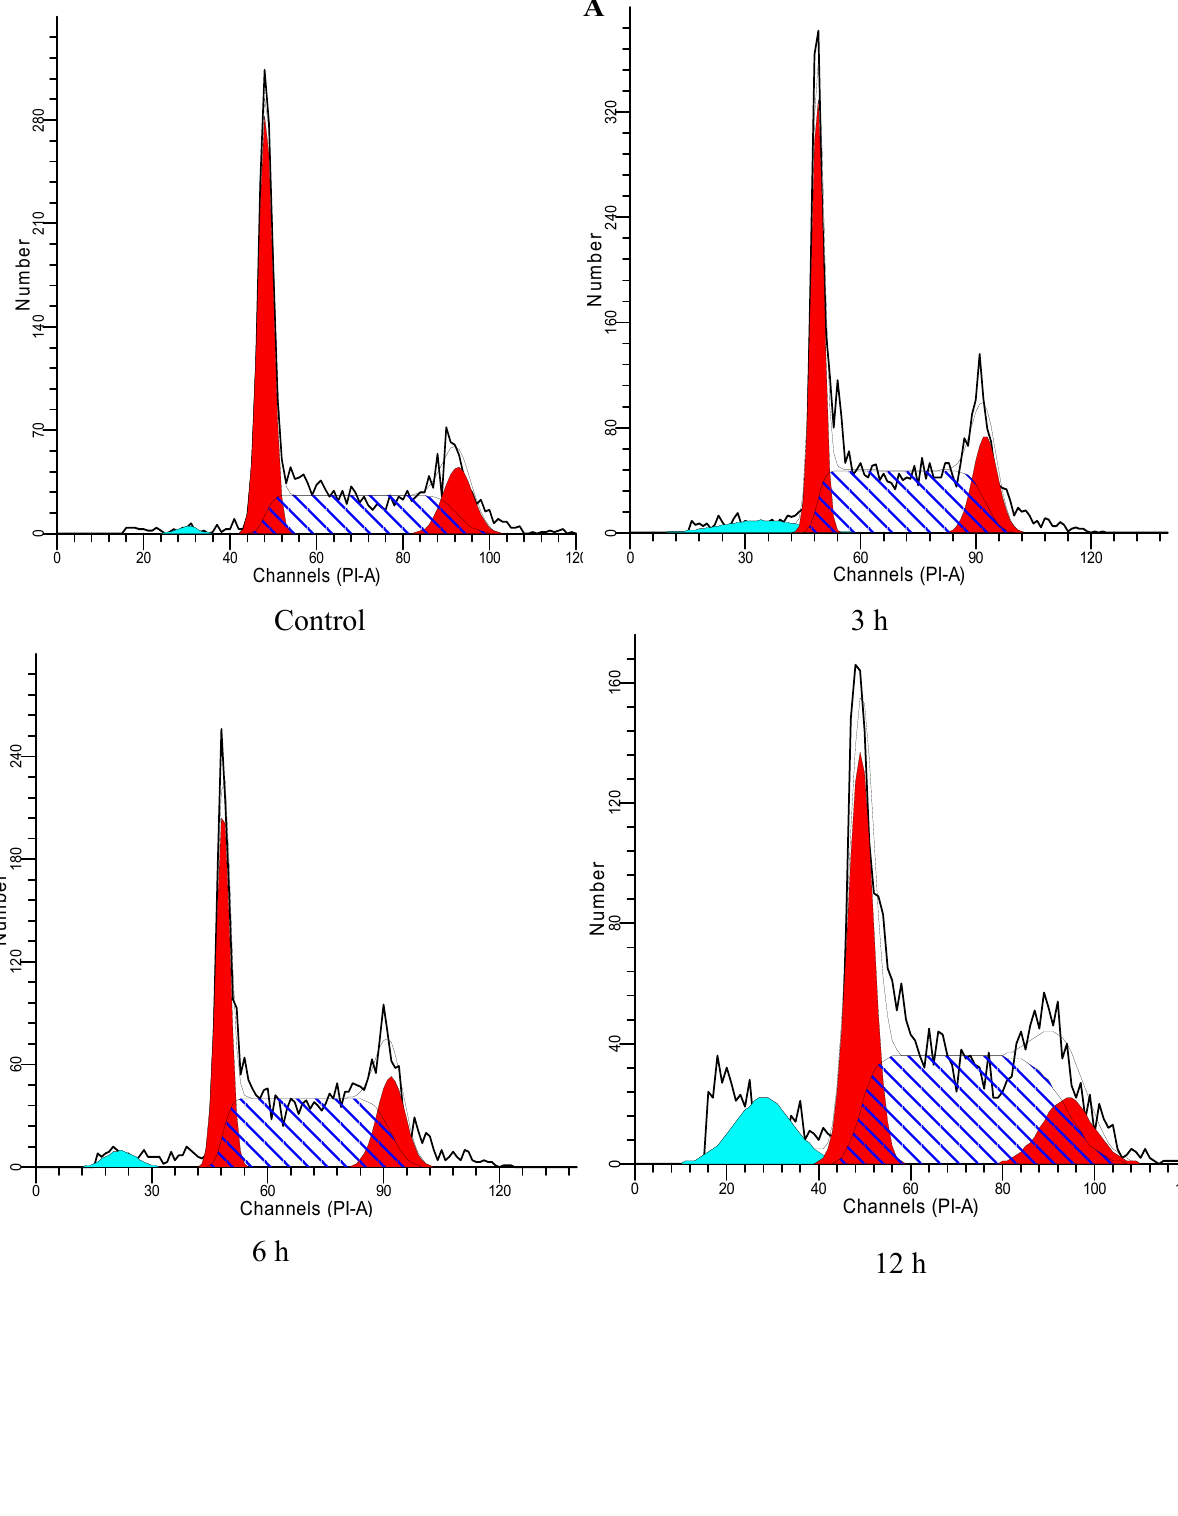
Figure 7. Histograms for cell cycle from analysis of CEMss cells treated with thymoquinone (1.5 µg/mL) ( A ). Results are representative of one of three independent experiments. Induction of S phase arrest in the cell cycle progression of CEMss cells thymoquinone ( B ). “*” Indicates a significant difference p <